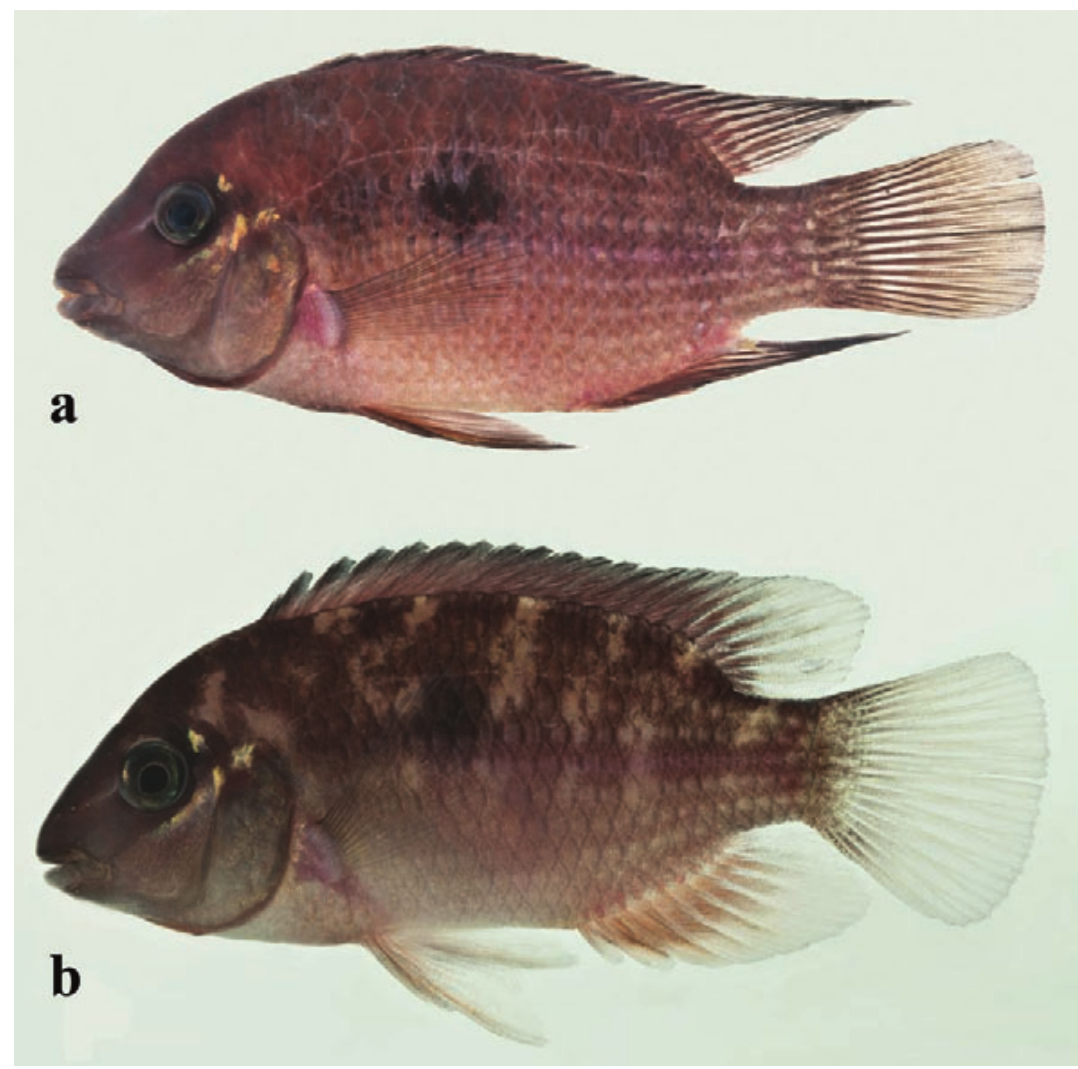
Fig. 13. Live colors of Mazarunia pala through ontogeny. a ) adult individual, probably male, 76.7 mm SL, ROM 89531, shortly after capture, b ) juvenile 50.0 mm SL, ROM 89675, shortly after